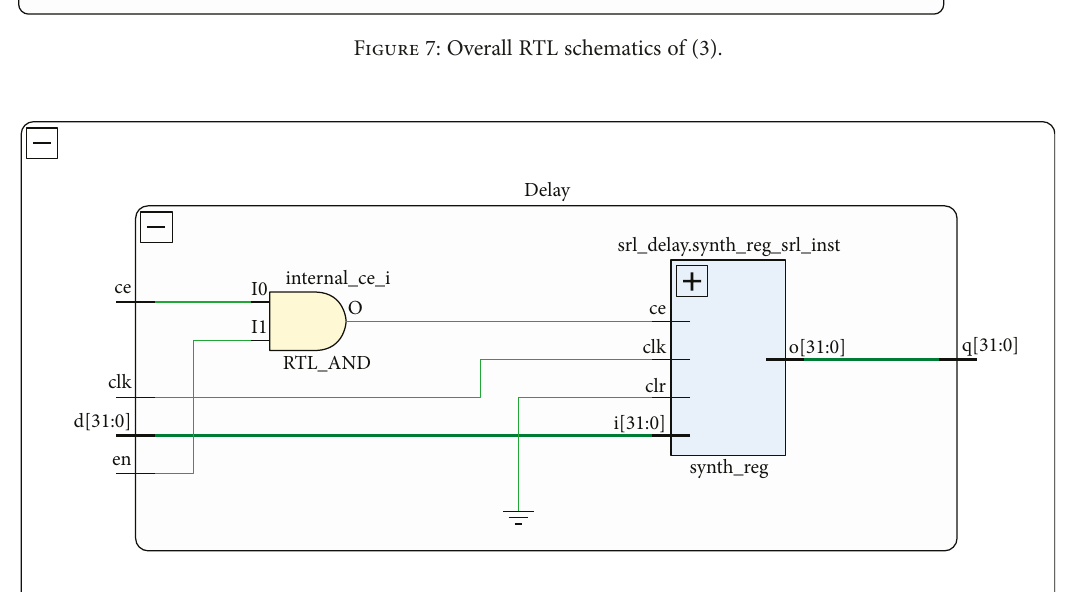
Figure 8: RTL schematics of the implemented delay